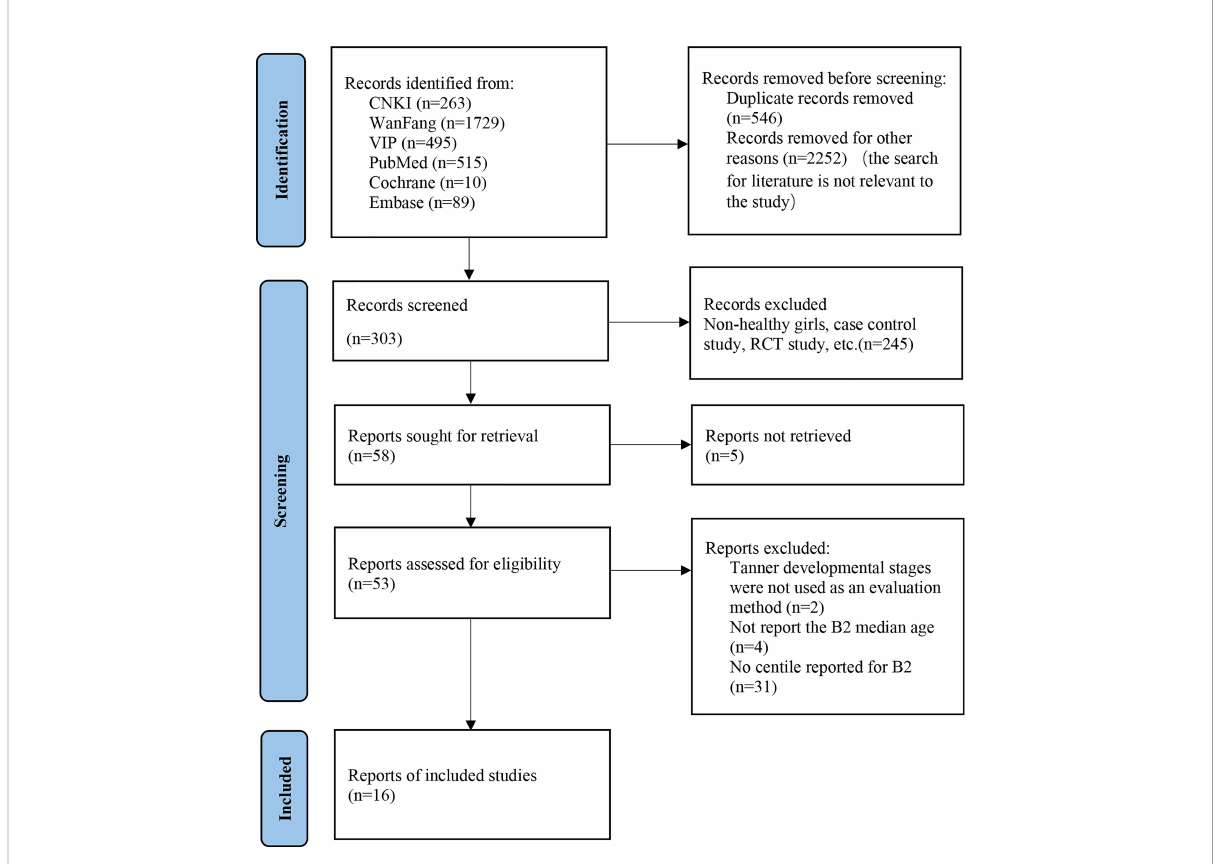
FIGURE 1 The PRISMA fl ow